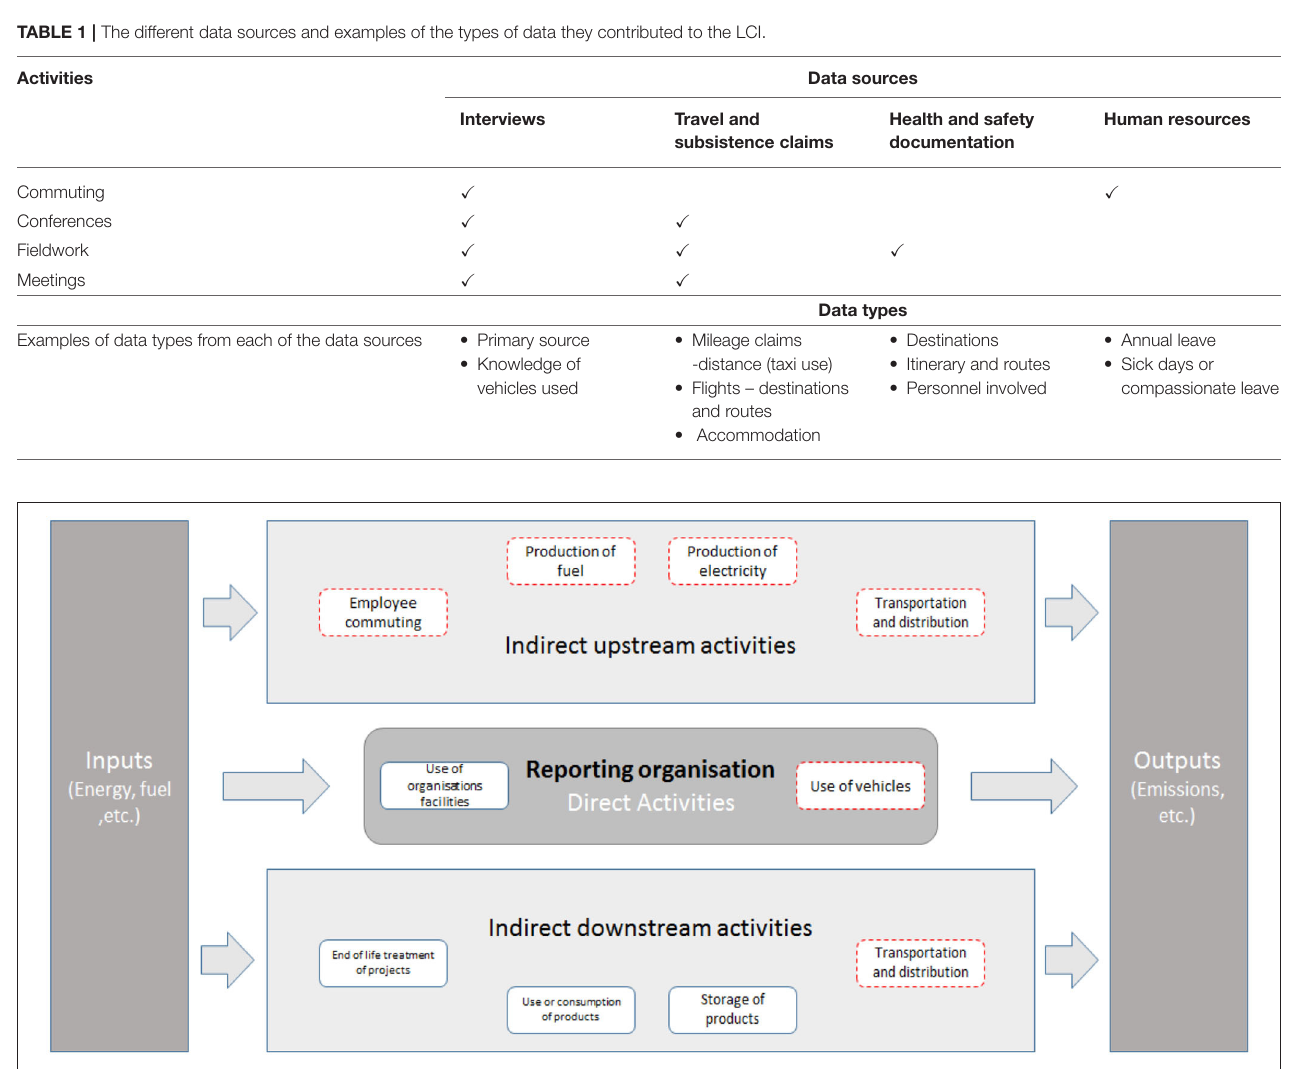
FIGURE 3 | The scope and activities associated with the operation of such a project. Boxes highlighted with red dashed lines indicate the activities assessed as part of the study. Figure adapted from the UNEP/SETAC O-LCA guidelines